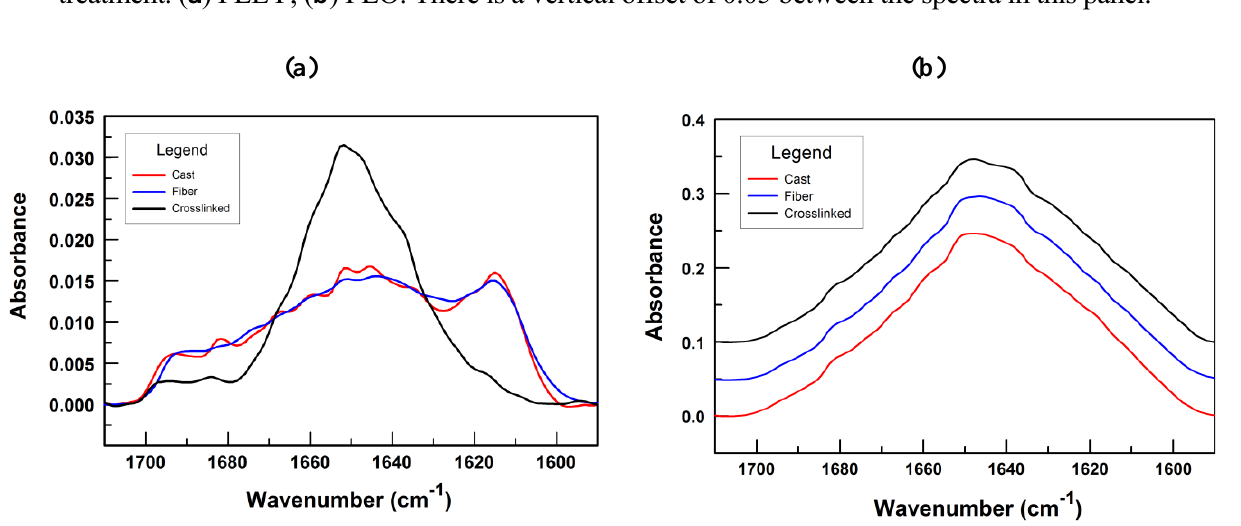
Figure 3. Infrared analysis of cast films and fibers. Cast film (red), fibers (blue) and crosslinked fibers (black). All but the amide I envelope was subtracted from the spectra during baseline treatment. ( a ) PLEY; ( b ) PLO. There is a vertical offset of 0.05 between the spectra in this